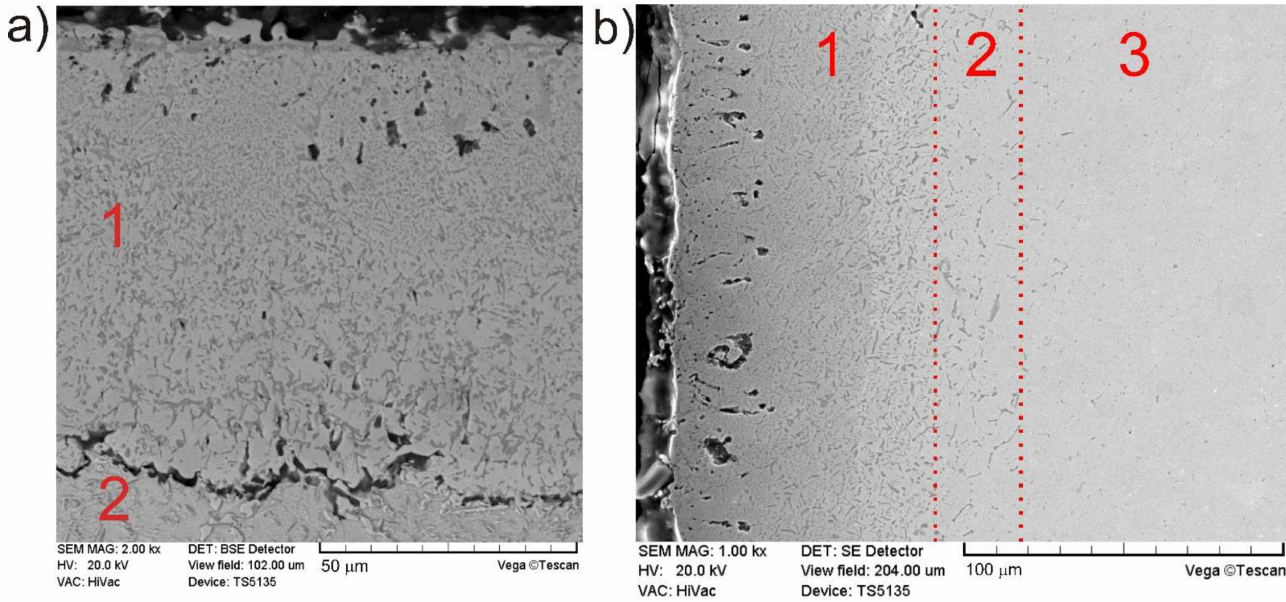
Figure 1. SEM microstructure of the gas-borided Inconel 600-alloy: ( a ) sample etched with Marble’s reagent, ( b ) sample without etching; (1)—compact zone of borides, (2)—zone with borides at the grain boundaries, (3)—substrate